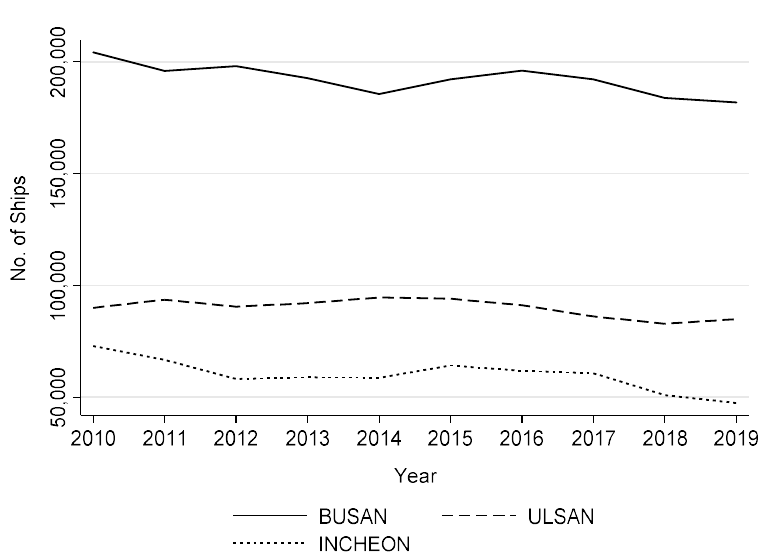
In all three ports, cargo ships that were not subject to the VSR program had the highest proportion of entry and departure. Meanwhile, other (ETC) ships, which are frequently operated, such as tugboats, barges, and pilot ships, accounted for a high proportion. The types of ships subject to the VSR program show that Busan Port and Incheon Port have the highest percentage of full-container vessels, whereas Ulsan Port has the highest per- centage of chemical carriers. Figure 1. Time-series graph of the total number of ships entering and leaving each port.